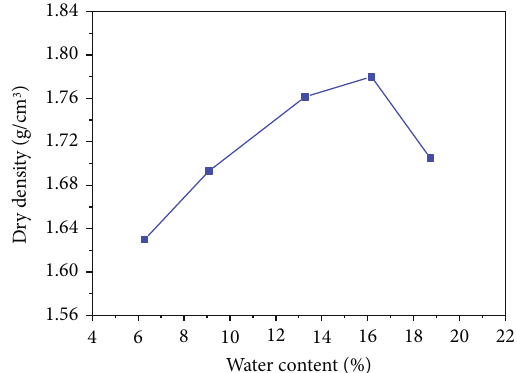
Figure 2: The relationship curve of water content and dry density of silty